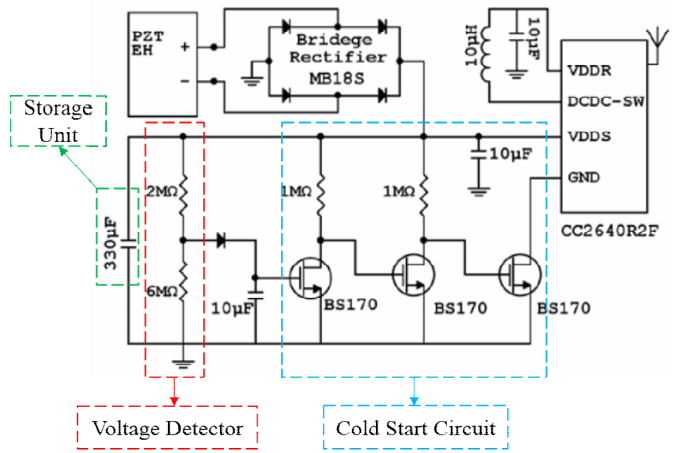
Figure 7. Detailed circuit schematic of the power conditioning module. The voltage detector detects the triggering information by actively monitoring the charging voltage across the storage unit. Once this voltage approaches the circuit threshold (3 V in this circuit), the circuit generates a trigger signal activing the Wireless MCU by starting the cold start circuit.